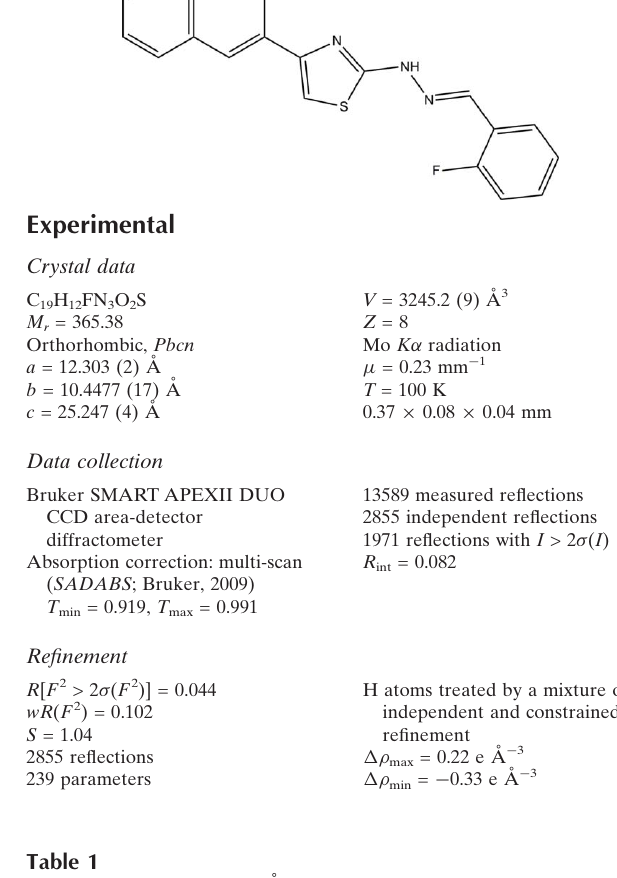
Hydrogen-bond geometry (A˚ , (cid:2)